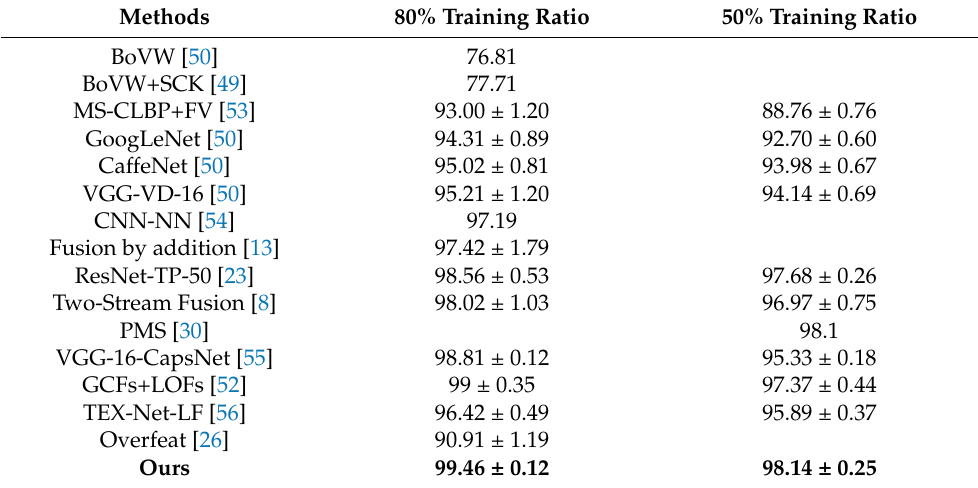
Table 2. The comparison of overall accuracy on the UC Merced Land Use dataset